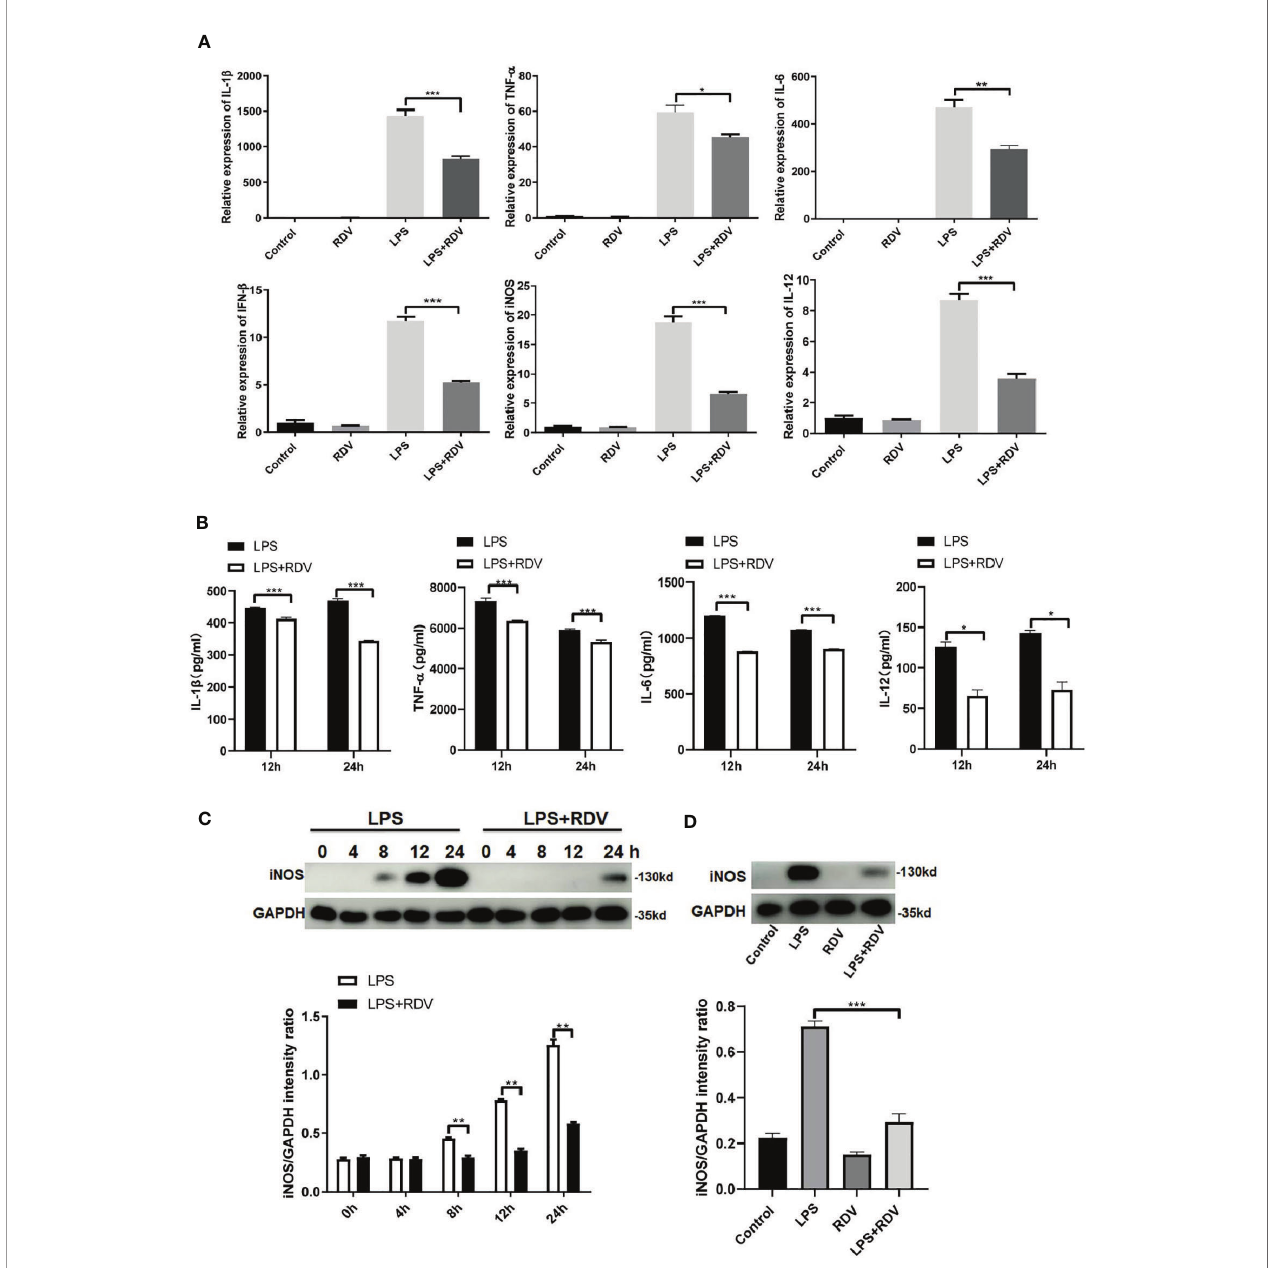
FIGURE 3 | RDV inhibits the expression of pro-in fl ammatory cytokines. (A) RT-PCR analysis of TNF- a , IL-6, IL-1 b , IL-12, iNOS, and IFN- b mRNA expressions in mouse peritoneal macrophages stimulated with LPS, RDV, LPS + RDV for 12 h. (B) ELISA analysis of TNF- a , IL-12, IL-6, and IL-1 b in cell culture supernatant stimulated with LPS and LPS+RDV for 12 h and 24 h and treatment with ATP in the last 40 min. (C) Western blot analysis of iNOS in mouse peritoneal macrophages under LPS and LPS+RDV stimulation at different time points and relative intensity analysis of iNOS. (D) Western blot analysis of iNOS in the kidney and relative intensity analysis of iNOS. Data are representative as mean values ± SD from three independent experiments. *P < 0.05; **P < 0.01; ***P <